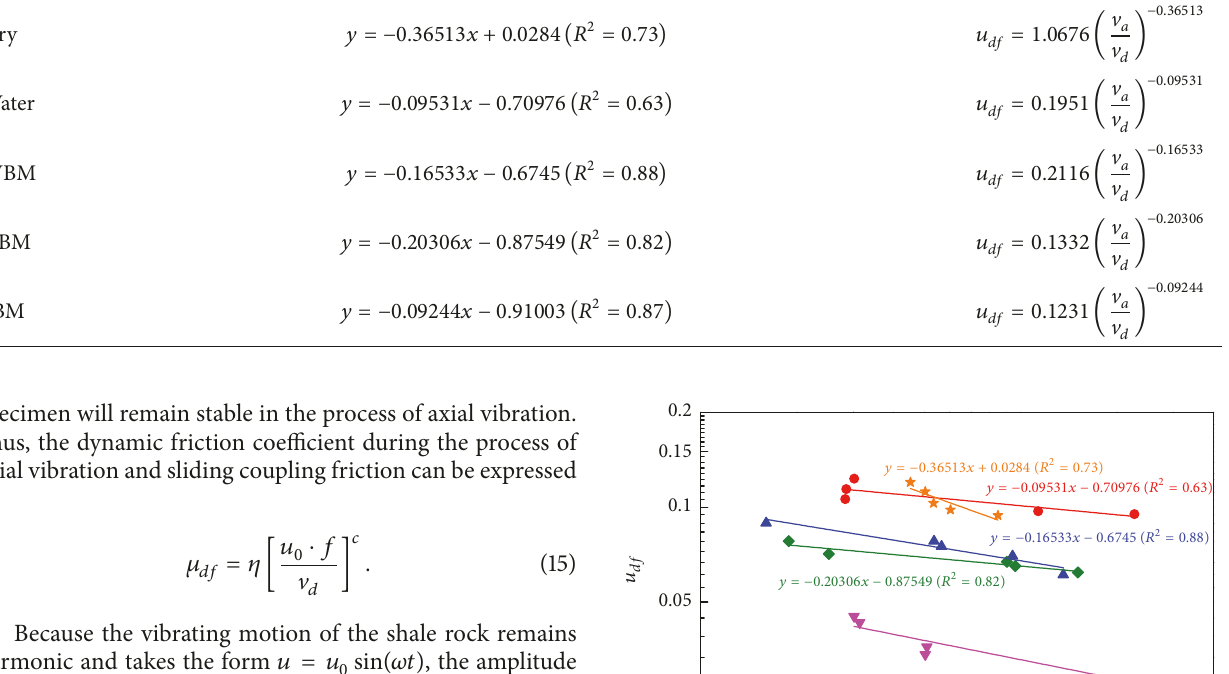
Table 5: The expressions of dynamic friction coefficient under different lubrication conditions. Medium